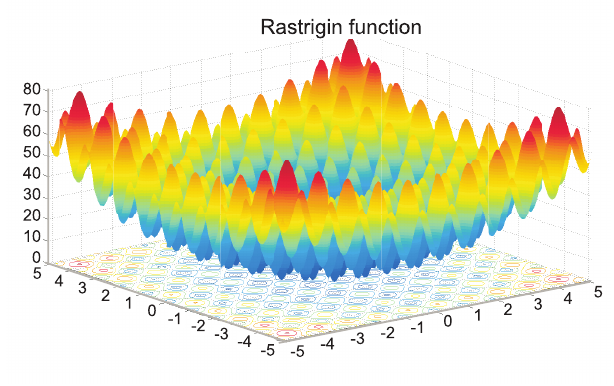
Figure 3. Graphical representation of the Rastrigin function used in the comparison of the Nelder-Mead, Hill Climbing, and Random Search algorithms with the adaptive genetic algorithm. Visualized in MATLAB 6.5: f = @(x,y) 10*2 + x.^2 + y.^2 – 10*cos(2*pi*x) – 10*cos(2*pi*y). The global minimum of the Rastrigin function is f (0,0) = 0.